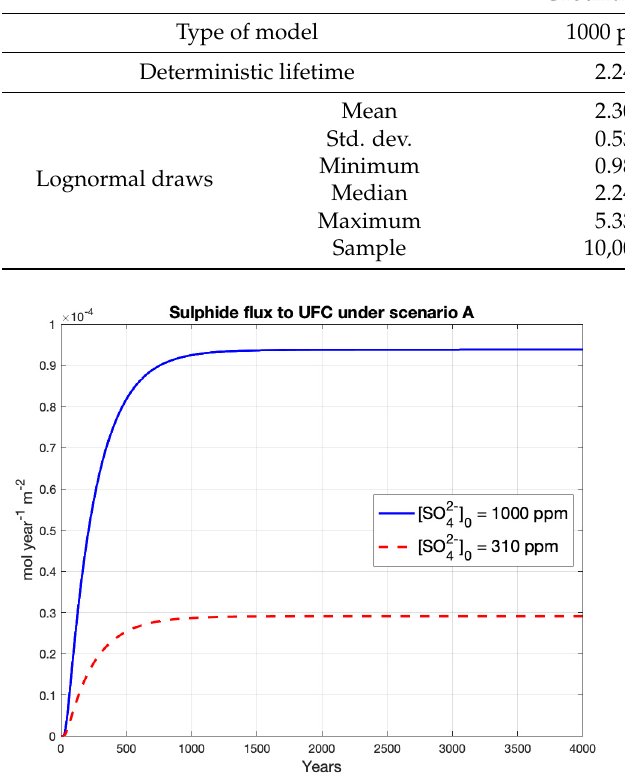
Figure 3. Histogram of UFC lifetimes under scenario A. 4.2. Scenario B This scenario, similar to A, has lifetimes above one million years for the deterministic model using both groundwater sulphate concentrations (Table 6). The flux of sulphide to the UFC is slightly higher than the previous scenario, yielding values of approximately 1.4 and 0.4 [mol year − 1 m − 2 ] for groundwater sulphate concentrations of 1000 and 310 ppm respectively (Figure 4). The steady-state sulphide concentrations at the rock interface are similar to those from scenario A, yielding values of approximately 4 and 1.2 ppm of sulphide for the sul- phate concentrations of 1000 and 310 ppm respectively (Figure A4 in Appendix A). Unlike scenario A, here the profile of sulphide concentration at a steady-state decreases nonline- arly as it reaches the UFC. The mean and medium lifetimes values are above one million years for the stochastic model. However, for the higher sulphate concentration simulation, lower than one-mil- lion-year lifetimes are possible. The minimum lifetime sampled is around 630,000 years and because the following relation is observed in the results: 𝐿𝑖𝑓𝑒𝑡𝑖𝑚𝑒 (cid:2869)(cid:2868)(cid:2868)(cid:2868)(cid:3043)(cid:3043)(cid:3040) ∗ 1000 = 𝐿𝑖𝑓𝑒𝑡𝑖𝑚𝑒 (cid:2871)(cid:2869)(cid:2868)(cid:3043)(cid:3043)(cid:3040) ∗ 310 , the sulphate concentration necessary to yield this minimum lifetime is 2300 ppm, which is an unlikely high value. A histogram of lifetimes of the UFCs for this scenario is shown in Figure 5.